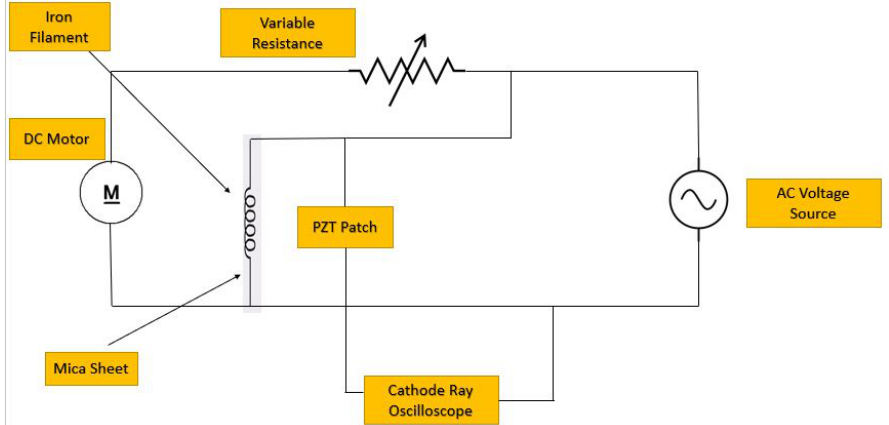
Figure 1. Electrical circuit of a thermo-electro-mechanical-based piezoelectric energy harvester (PEH) (iron filament is used for thermal shocking; function generator is used for electrical shocking; DC motor with CAM shaft is used for mechanical loading; decade box is used to shock PZT externally at variable resistance; PZT has internal resistance R o ; mica sheet is used for thermal and electrical insulation; Cathode ray oscilloscope (CRO) is used for data acquisition).